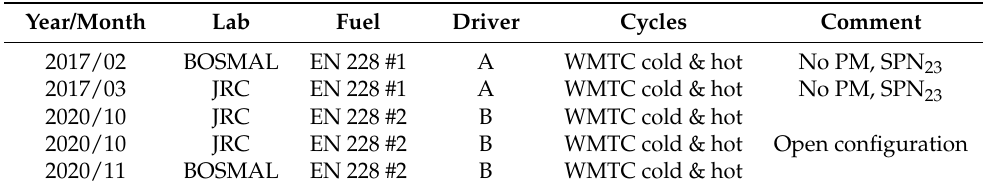
Table 1. General overview of the measurement campaigns in 2017 and 2020. For the additional tests with “open configuration” setup, see Figure 1. “No PM, SPN 23 ” means no measurements were taken for the specific